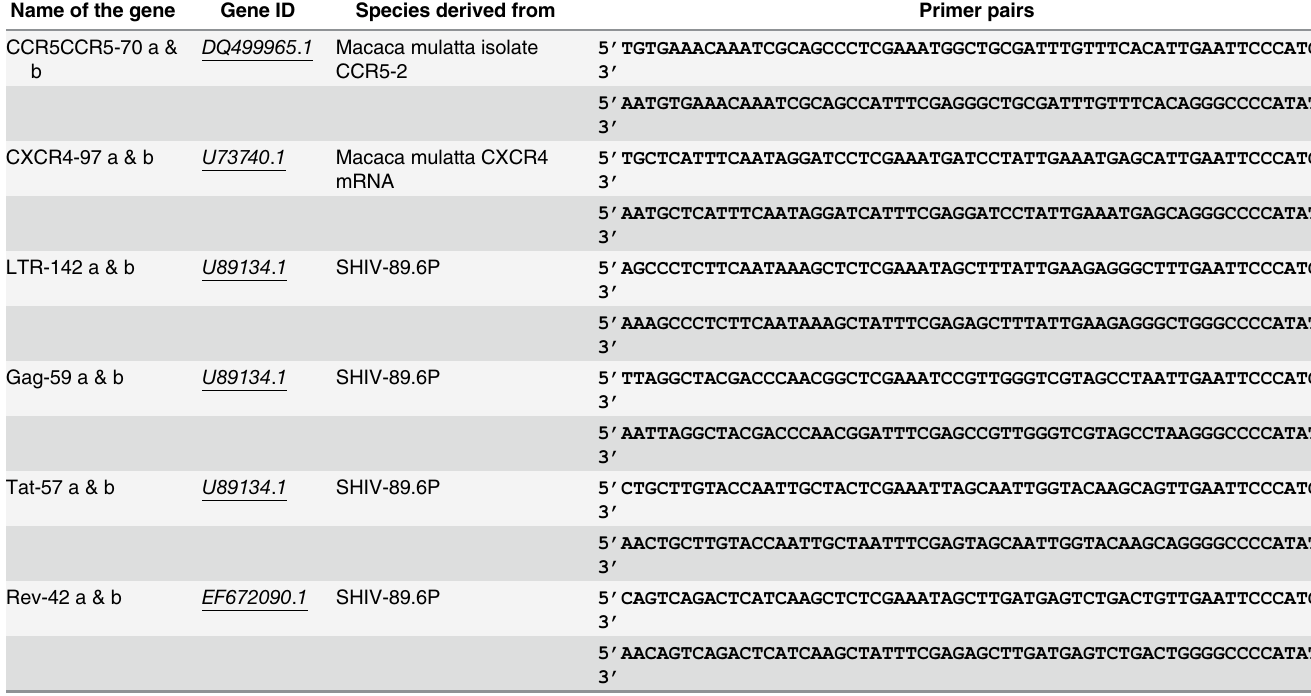
Table 1. List of genes and siRNA primer sequences. Name of the gene Gene ID Species derived